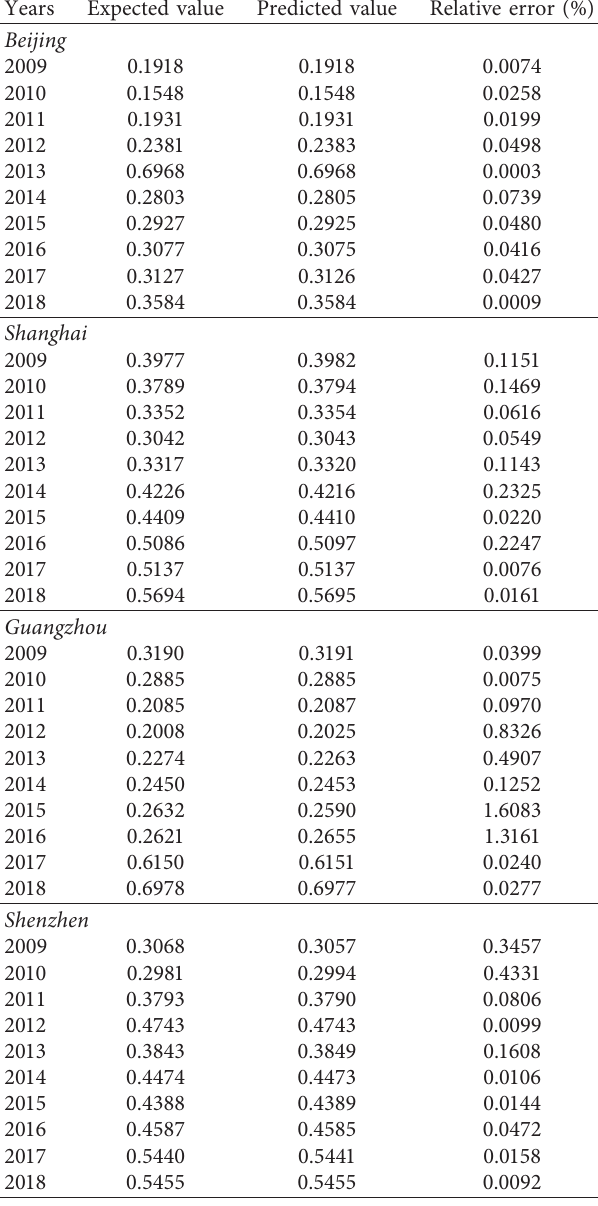
Table 4: Comparison of actual value and predicted value of the TOPSIS-BP neural network